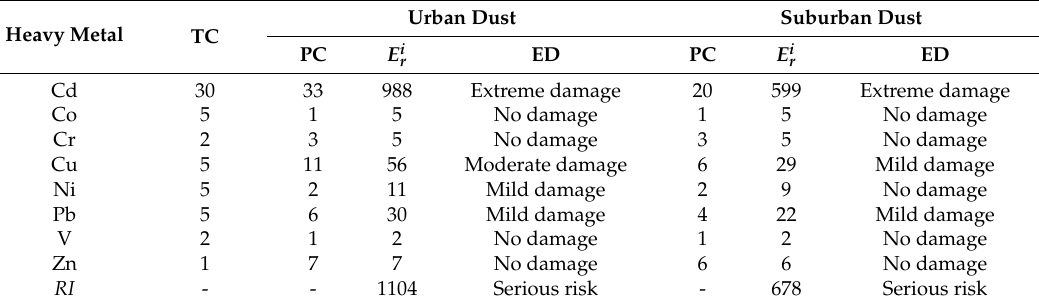
Table 8. The potential ecological risk index of heavy metals of dust during winter in Beijing. Heavy